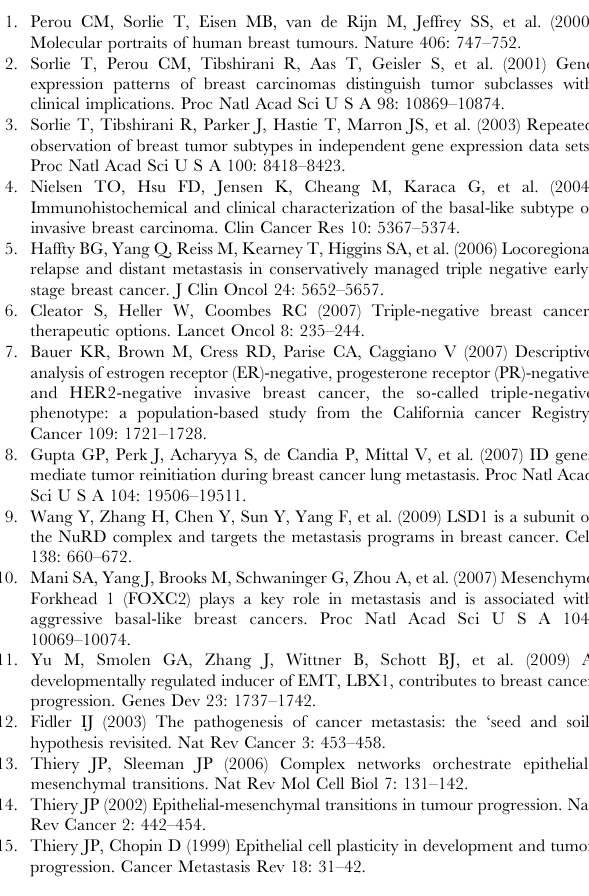
Figure S4 ChIP assays at the E-cadherin promoter. Increased binding of HDAC1 and HDAC2 at the E-cadherin promoter in the presence of NEDD9. Primer 1 and 2 were used to amplify the E-cadherin promoter regions from 2 600 to 2 329 and 2 359 to 2 63, respectively. Table S1 Patient and tumor characteristics of 84 cases of primary invasive breast carcinoma analyzed by immunohistochemistry. (DOC) Methods S1 Quantitative